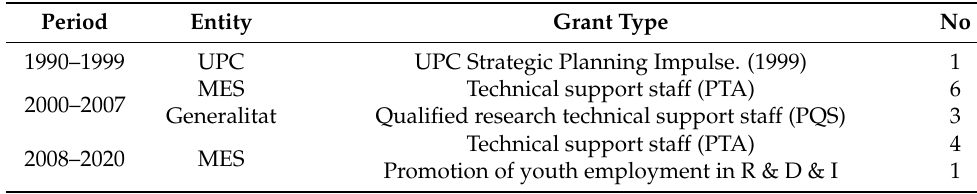
Table 8. Co-financing for the hiring of research support technicians.